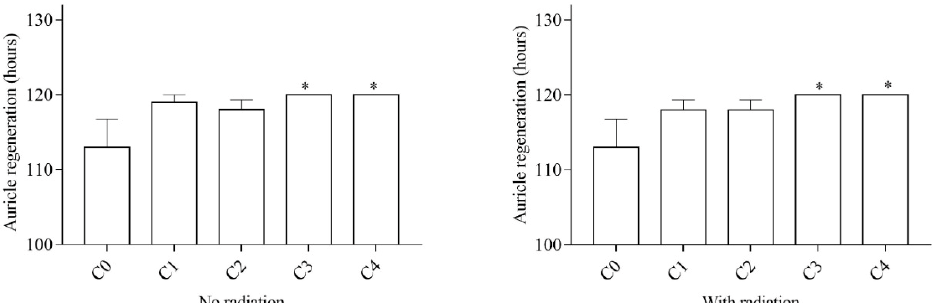
Figure 2. Chronic tests with G. tigrina : Auricle regeneration (No radiation F 4,55 = 2.513 p < 0.05; With radiation F 4,55 = 2.313, p < 0.05). * Each bar represents mean ± SD (n = 5 animals/group/replicates). Compared to the control, a significantly increased delay in the formation of photoreceptors was measured in the C1–C4 treated groups (Dunnett’s test).